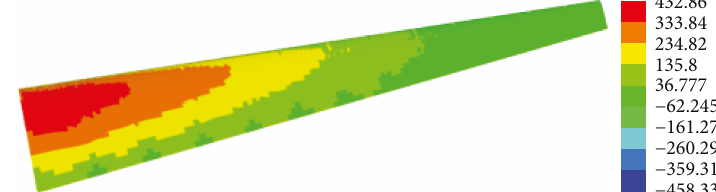
Figure 37: Stress cloud diagram of the lower wing with the layer angle being 45 and 90.